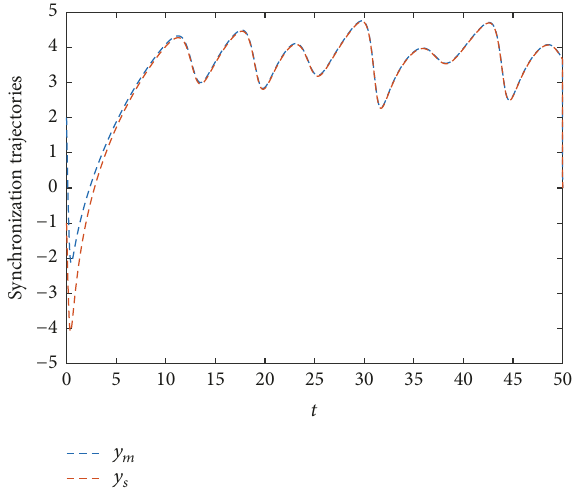
Figure 4: The synchronization trajectories of 𝑦 𝑚 , 𝑦 𝑠 .